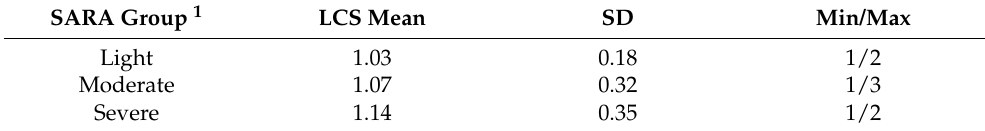
Table 3. LCS means of cows in the three SARA groups during the study period.